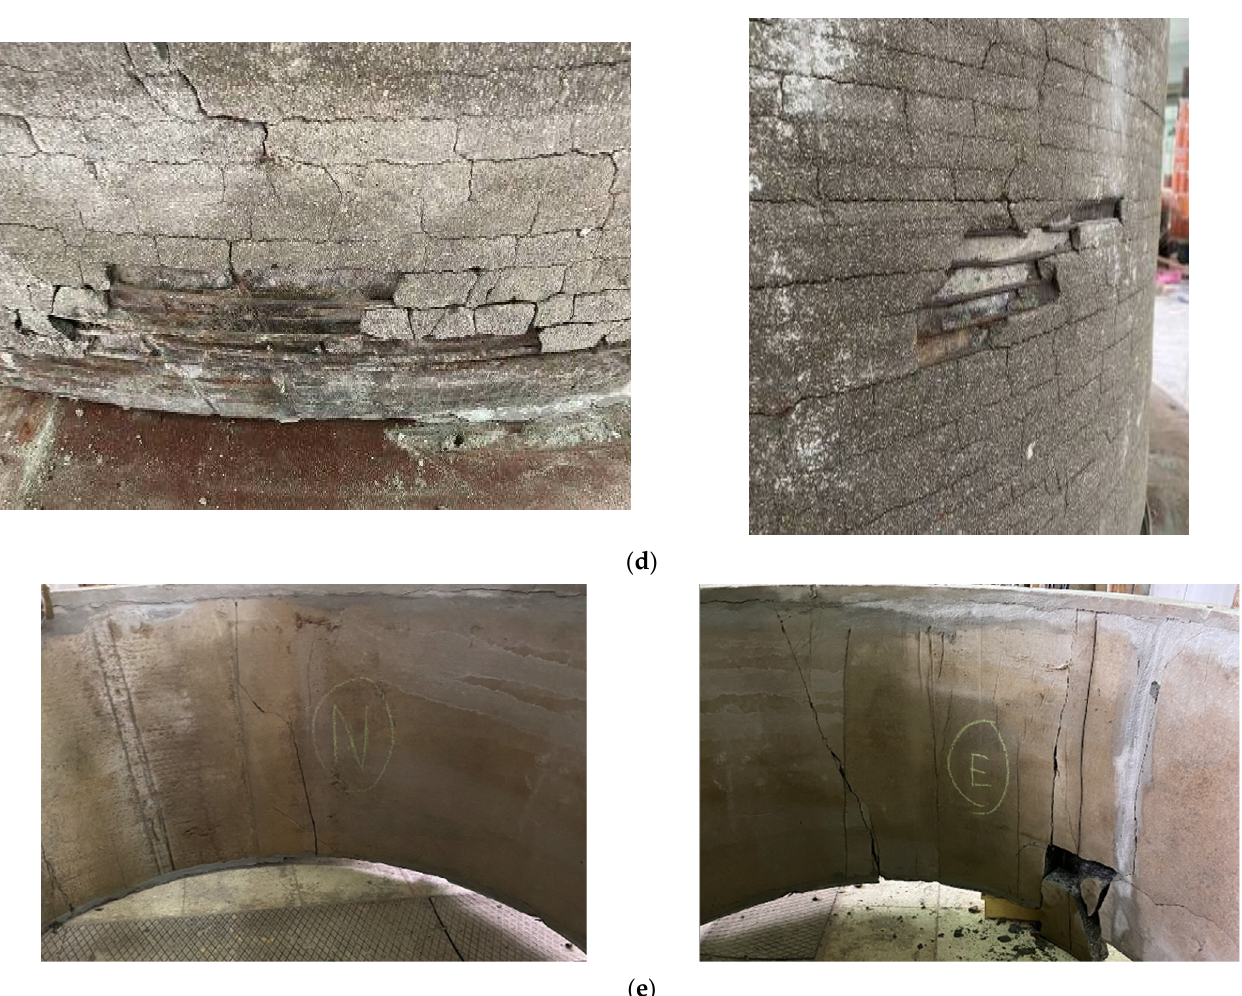
Figure 25. ( a ) Specimen 1 with an external RC jacket and fully active prestressing wires after the internal hydraulic pressure test. Concrete micro ‐ cracking visible at the internal concrete surface. ( b ) Specimen 3 with an external FRP jacket and fully active prestressing wires after the internal hydraulic pressure test. ( c ) Specimen 5 with internal FRP jacket and fully active prestressing wires after the internal hydraulic pressure test. Identified micro ‐ cracking at the external concrete surface. ( d ) View from different sides of the external surface of Specimen 7 with fully active prestressing wires after the internal hydraulic pressure test. ( e ) Internal surface and concrete cracking of Specimen 10 with inactive prestressing wires.